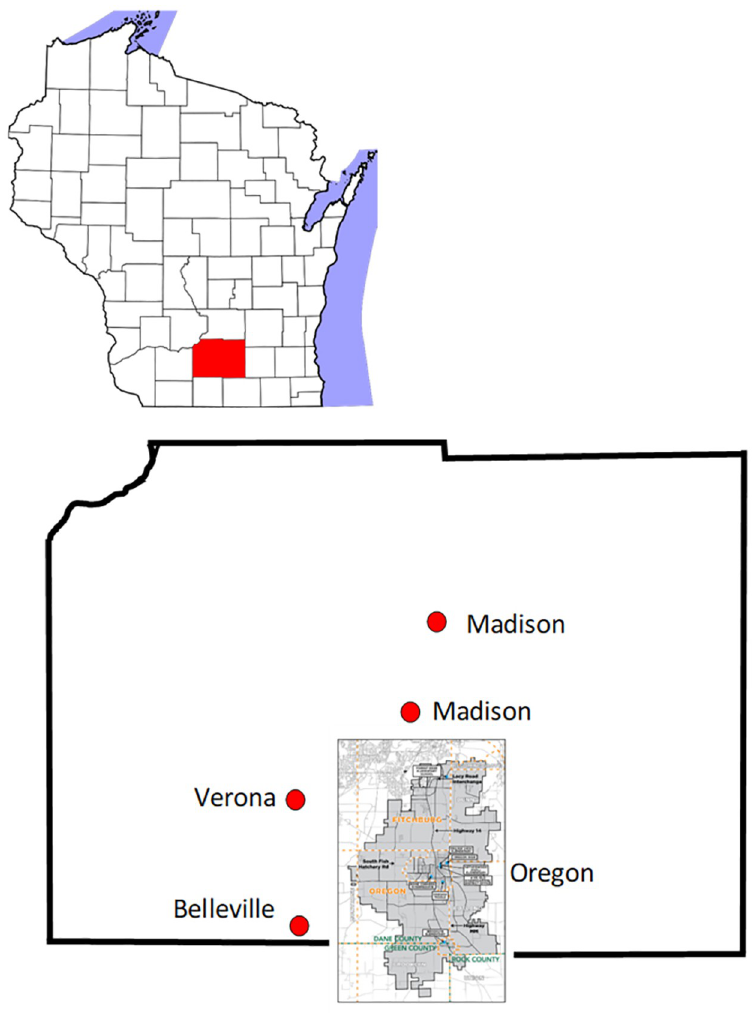
Fig 2. Location of the Oregon School District (OSD) in the villages of Oregon and Brooklyn in South Central Wisconsin. The red dots depict locations of family medicine clinics that participate in long-term surveillance of medically-attended